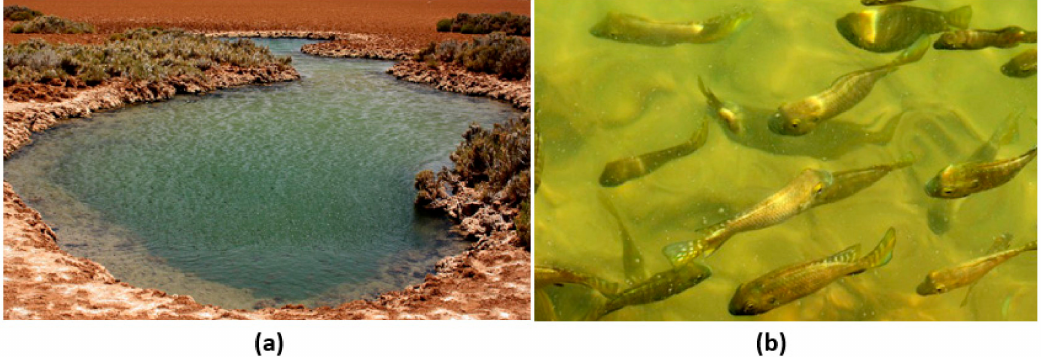
Figure 1. A permanent water cavity in Imlili Sebkha ( a ) holding a fauna of the Tilapia species ( b